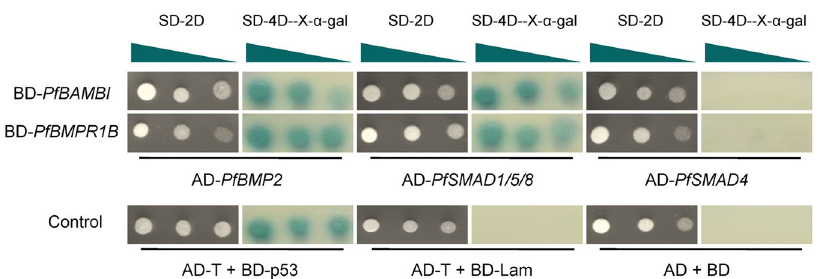
Figure 3. Interactions among Bambi, Bmpr1b and members of the TGF β /BMP signaling pathway in Pinctada fucata detected by a yeast two-hybrid system. The plasmids are cotransformed into the yeast AH109 and spread on the dropout synthetically defined (SD) medium. The white colonies on SD-Leu-Trp medium (SD-2D) indicate that the plasmids are successfully transformed. The blue colonies on SD-Ade-His-Leu-Trp/X- α -Gal medium (SD-4D- X- α -Gal) indicate the presence of an interaction between two proteins, comparable with that of the positive (AD-T + BD-p53), negative (AD-T + BD-Lam) and empty plasmid (AD + BD) controls. The triangle indicates that the yeast is gradient diluted five times with sterilized water before spreading on the